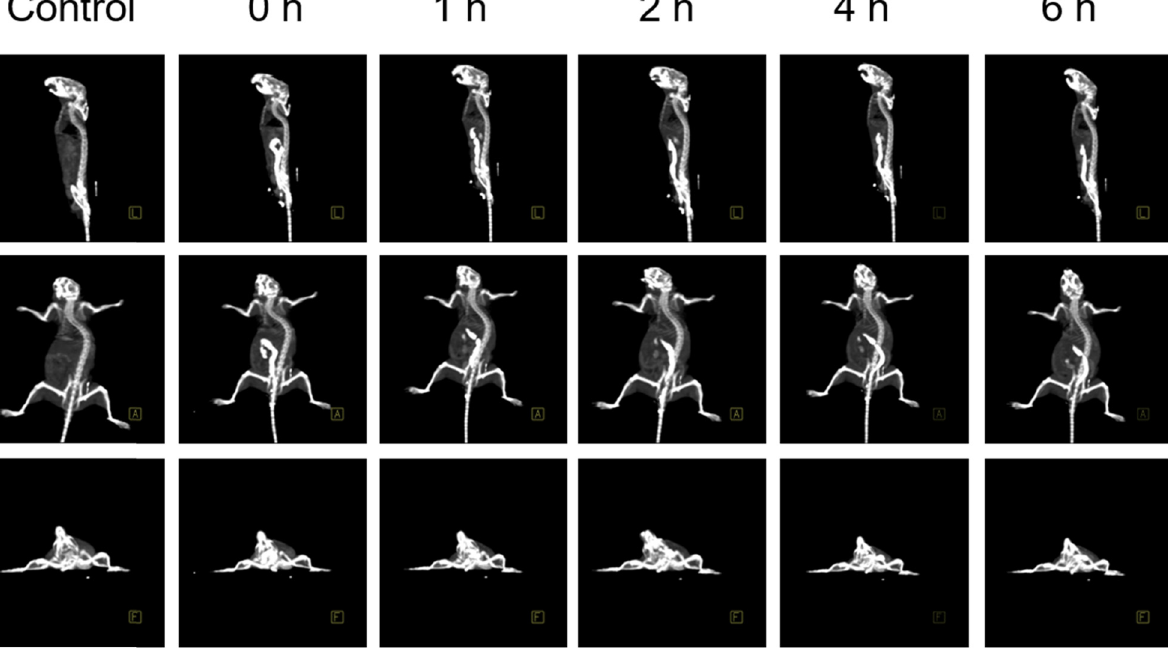
Figure 8: In vivo CT images of mice treated with AH - CS - I Ns at di ff erent times